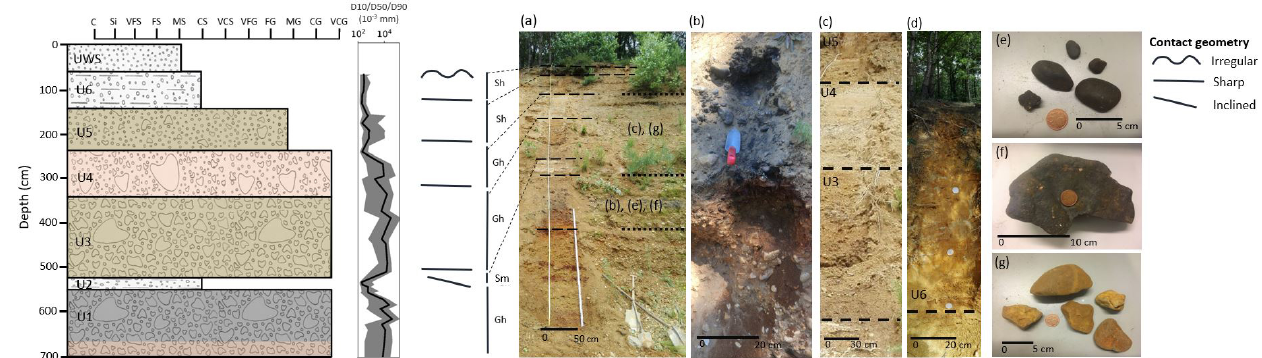
Figure 4. Field observations used to constrain simulations. The log illustrates six units, labelled from U1 to U6, that were defined based on grain size, contact geometry, sedimentary structure, sorting and weathering traces observed in the field. The maximum grain size of the units is shown on the top x axis (C: clay, Si: silt, VFS: very fine sand, FS: fine sand, MS: medium sand, CS: coarse sand, VCS: very coarse sand, VFG: very fine gravel, MG: medium gravel, CG: coarse gravel, VCG: very coarse gravel). They are covered by Weichselian, aeolian coversands (abbreviated UWS). U1, U3 and U4 present imbrication and represent crudely bedded gravels (Gh). U2, U5 and U6 represent horizontally bedded sands (Sh) or pebbly fine to very coarse sands (Sp). The granulometry is illustrated by the D50 (black line), and the limits of the shaded area define the D10 on the left and the D90 on the right of the black line. Panels (a) – (d) represent illustrations of the different units. Panels (e) – (f) represent very coarse gravels collected in U1 showing Mn coatings. Panel (g) illustrates weathered gravels from U3 showing Fe